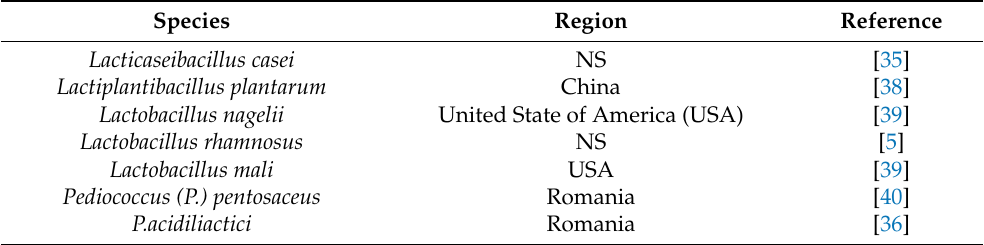
Table 2. LAB isolated from